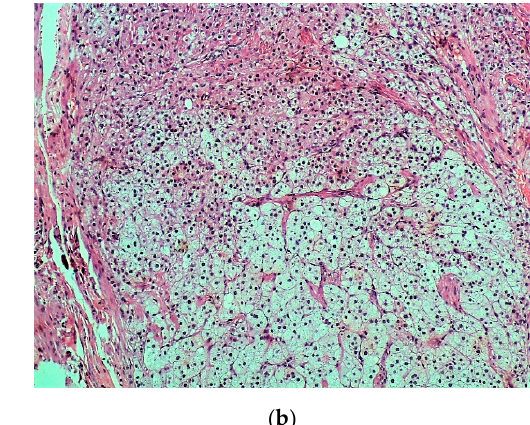
Figure 2. ( a , b ). Nodule: vacuolated lipid-rich cell population (zona fasciculata) admixed with a lesser population of eosinophilic or amphophilic cells (zona glomerulosa) (H & E, × 100).